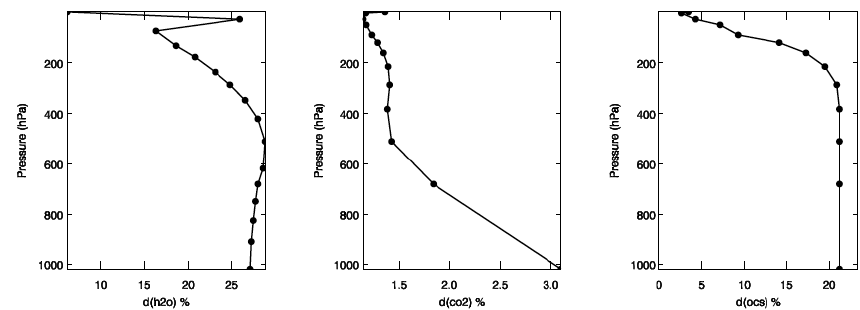
Fig. 3. Square root of the diagonal values of the covariance matrices for H 2 O, CO 2 , and OCS.